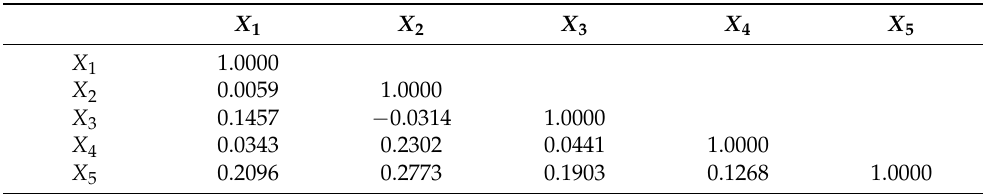
Table 6. Correlation analysis.